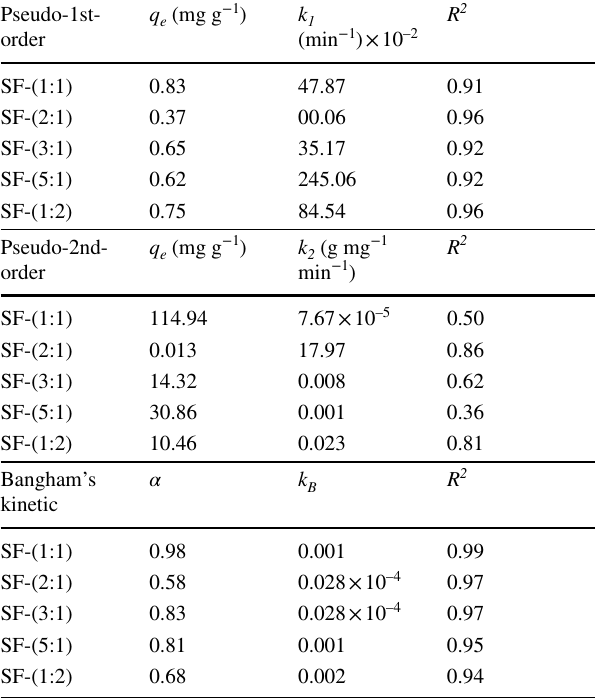
Table 2 Pseudo-first, second-order and Bangham’s kinetic constants for the removal of textile dying effluent by different adsorbents Pseudo-1st- order